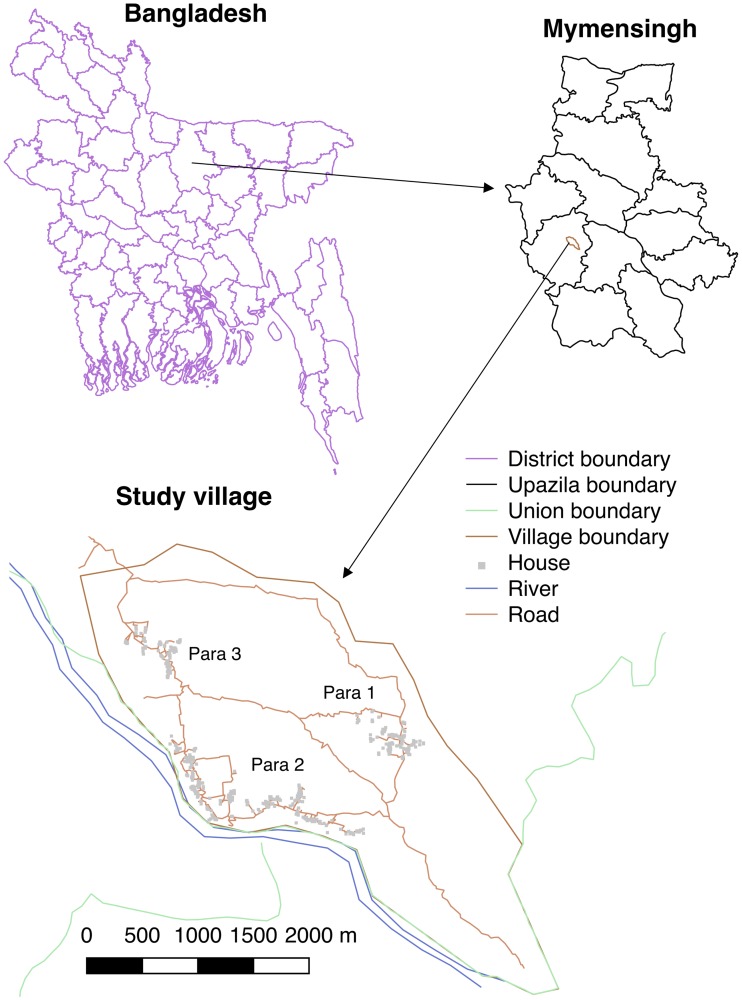
Location of study village and surveyed households in Fulbaria upazila, Mymensingh district, Bangladesh.District and upazila shape files from www.gadm.org/country, village details from GPS mapping during study. Maps produced using QGIS version 2.14.2 [64].